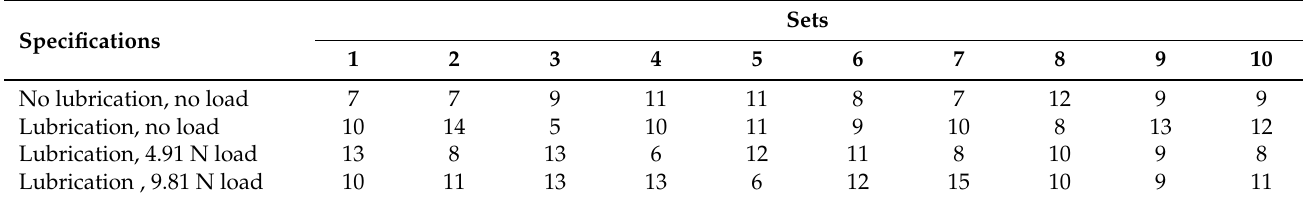
Table 4. Distribution of measurements in validation